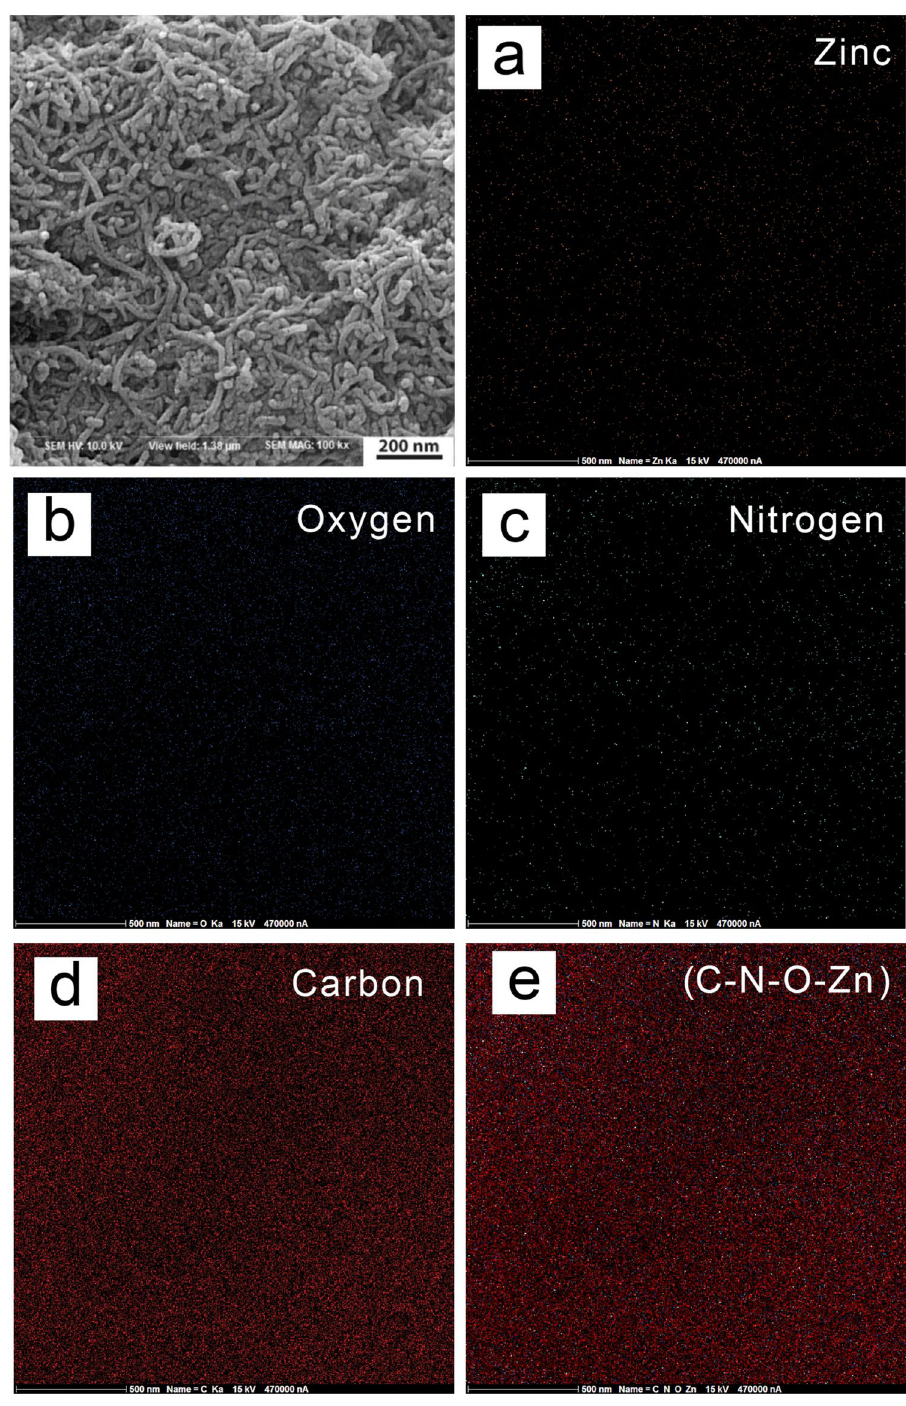
Figure 3. Elemental mapping of MWCNTs/ZnO/Chitosan